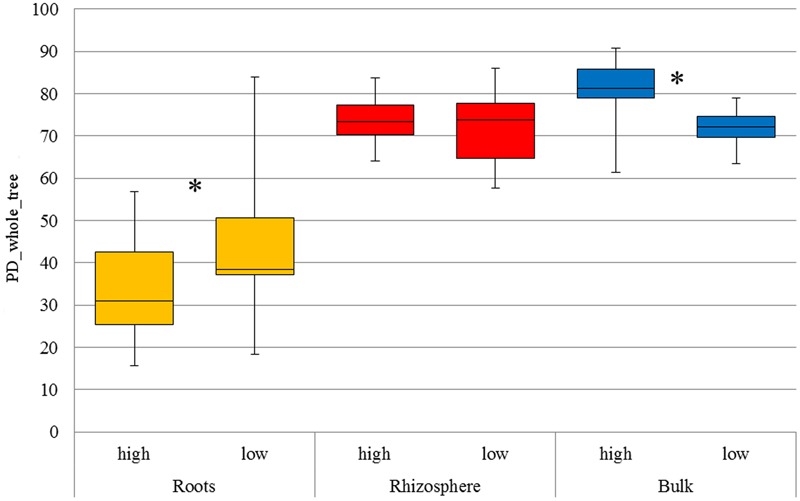
Faith’s phylogenetic diversity of all compartments under low and high land use intensity, respectively. The distribution of phylogenetic diversity is shown at 97% sequence similarity. The boxplot indicates the first and third quartile. The median is indicated as horizontal line and whiskers indicate minimum or maximum, respectively. Significant differences among land use intensities are indicated with an asterisk (t-test, p < 0.05).